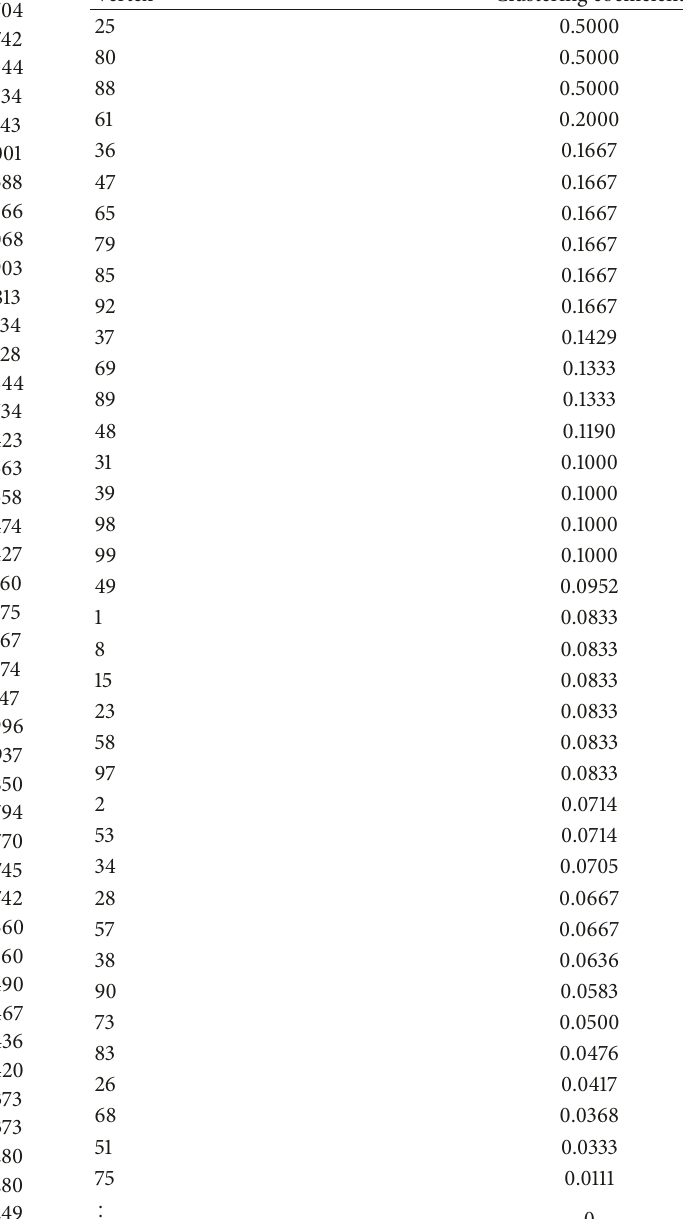
Table 6: Clustering coefficient in